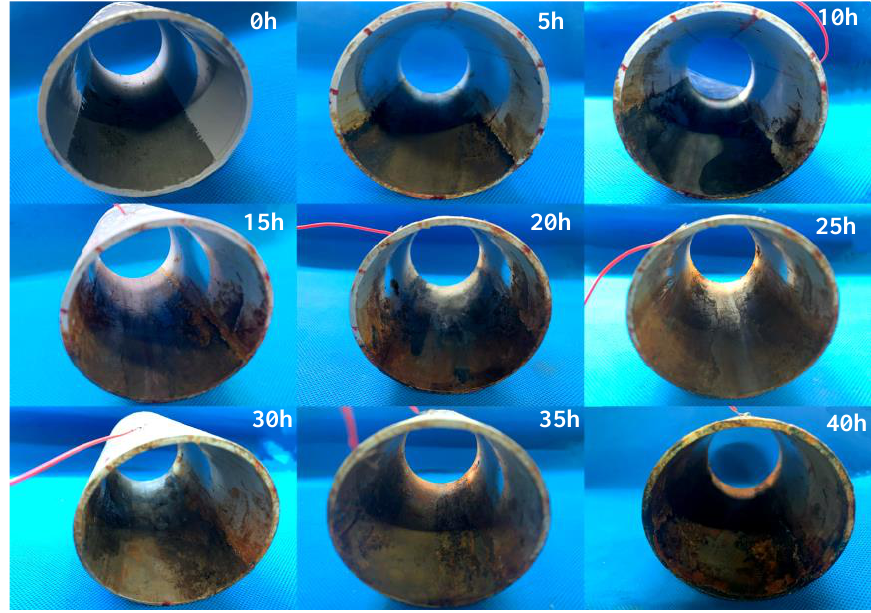
Figure 5. Pipeline status under different operating conditions.